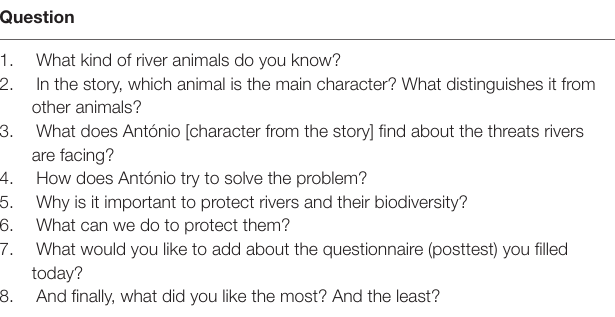
TABLE 2 | List of pre-determined questions used to facilitate the focus group